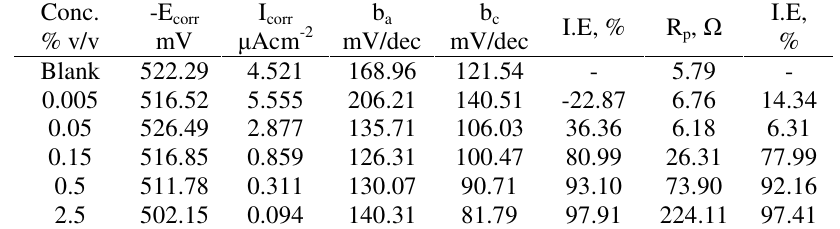
Table 5. Electrochemical parameters for mild steel in 1 M HCl containing CAL extract. Conc.